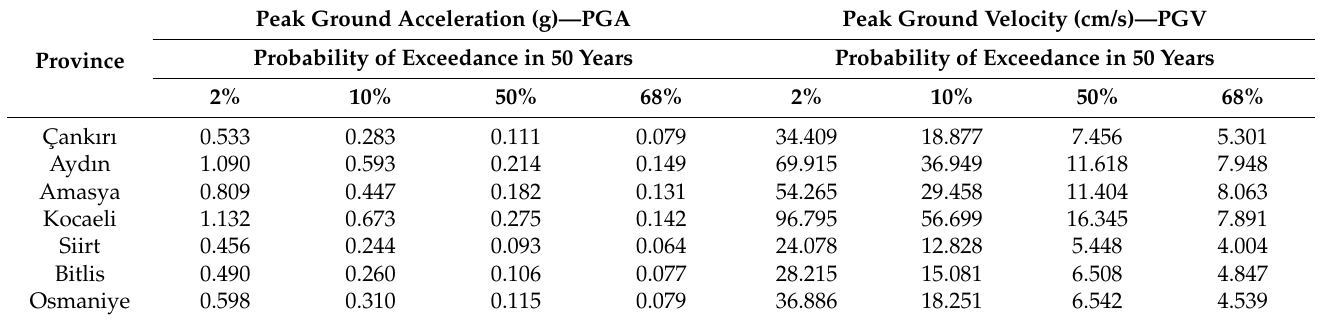
Table 4. PGA and PGV values for selected settlements for different ground motion levels.